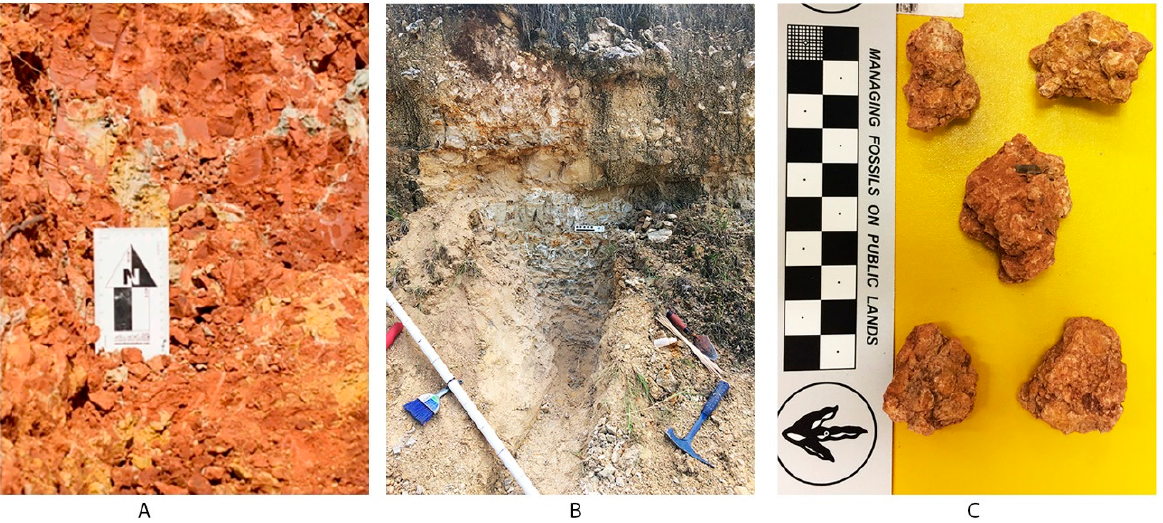
Figure 2. Paleosol outcrops and pedogenic features: ( A ) a cross section of the vertic Calcisols docu- mented at the Proctor Lake locality with an arrow scale bar of 10cm (Twin Mountains Formation); ( B ) a cross section of the outcrop at the Jones Ranch locality (Twin Mountains Formation); ( C ) pe- dogenic carbonate nodules recovered from the Oklahoma locality (Antlers Formation).